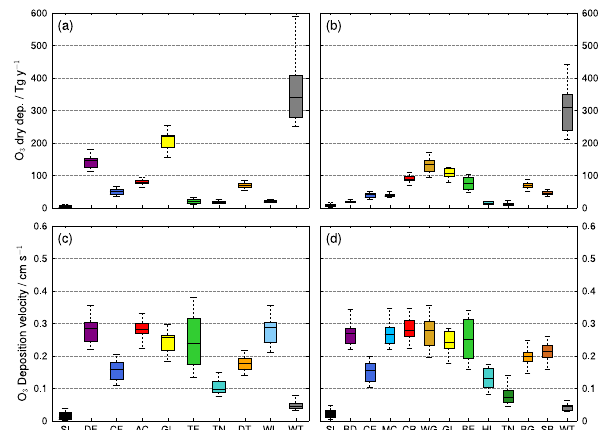
Figure 4. Total annual O 3 dry deposition and annual average O 3 de- position velocity partitioned to land cover classes using the OW11 (a, c) and GLCF (b, d) data sets. Upper panels show the contribution of each LCC to the global annual O 3 dry deposition flux, and lower panels show the average deposition velocity to each LCC. The box and whiskers for each land class represent the median, quartiles and 10th/90th percentiles over the 15 contributing